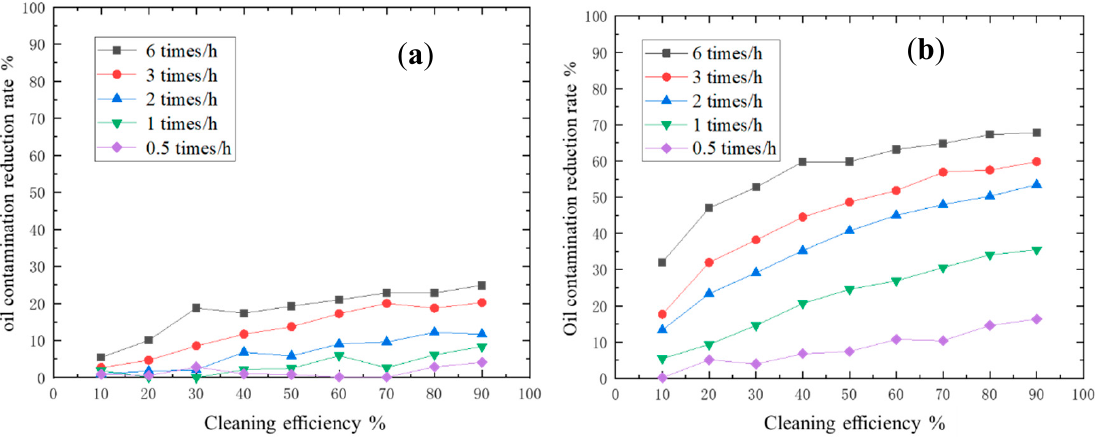
Figure 9. Relationship between oil contamination reduction rate on all surfaces and different cleaning rates under different cleaning frequencies: ( a ) cleaning the worker’s gloves and ( b ) cleaning the workbench in the production area.